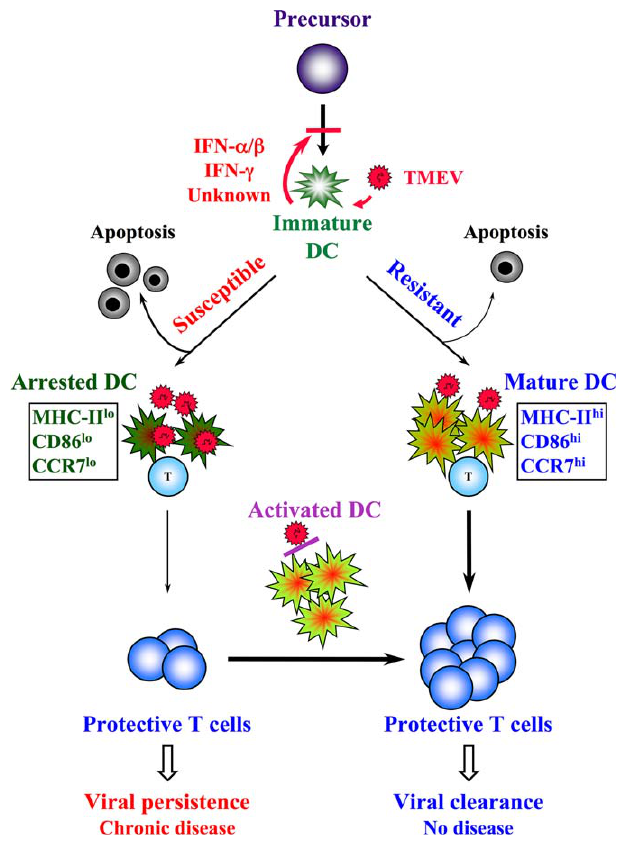
Figure 8. Schematic Presentation of the Potential Role of DCs in Differential Susceptibility to Viral Persistence TMEV preferentially infects immature DCs and induces the production of anti-viral IFN- a / b , IFN- c , and unknown cytokines. DCs from susceptible mice are more permissive to viral infection and viral-induced apoptosis, and produce higher levels of these cytokines compared to DCs from resistant mice. These cytokines inhibit the development of DCs from BM cells in a dose-dependent manner, leading to arrested maturation and compromised function, while these cytokines can be protective when exposed to DCs prior to viral infection. Consequently, susceptible mice exhibit severely reduced levels of functionally mature DCs for T cell activation, resulting in poor anti-viral T cell responses, and perhaps, preferential non-protective or pathogenic T cell responses. Adoptive transfer of LPS-pre-activated syngeneic DCs, which are resistant to viral infection, renders susceptible mice resistant to viral-induced demyelinat- ing disease by elevating protective T cell